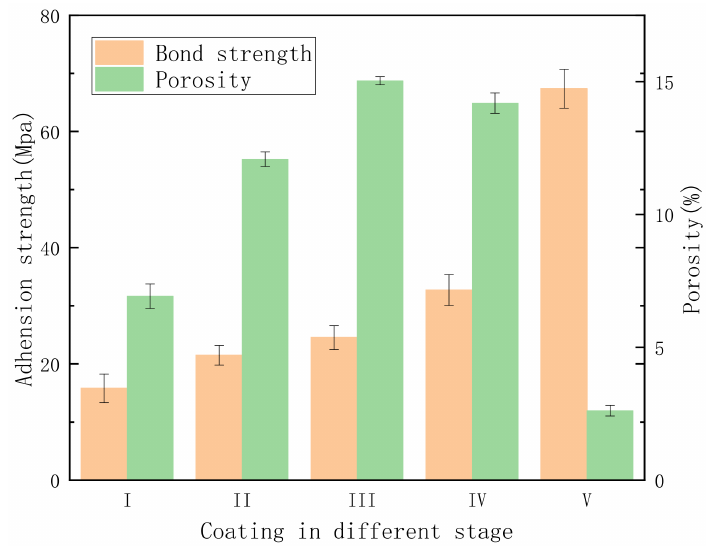
Figure 10. Adhesion and porosity of PEO coatings at different